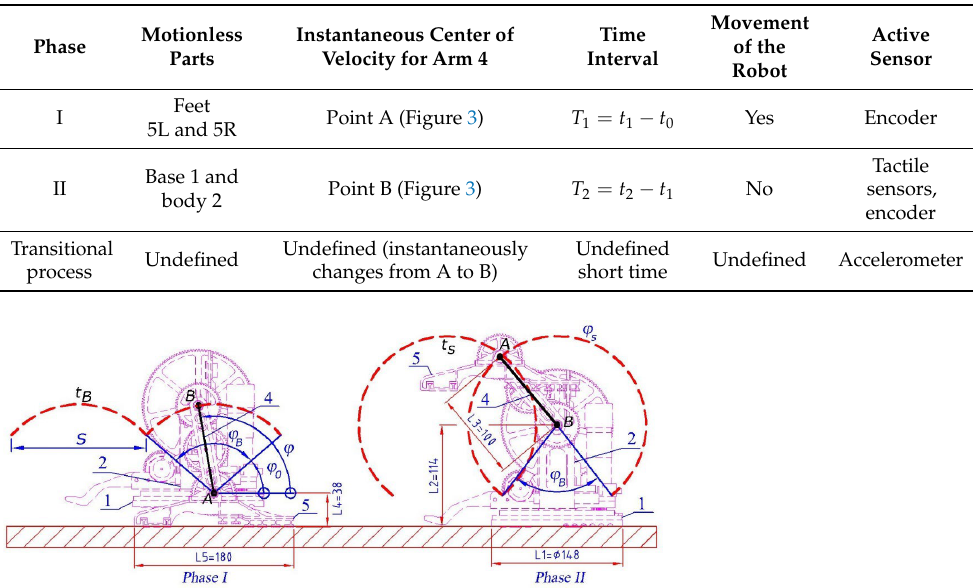
Figure 3. Walking phases (on even horizontal surface) for the robot “Big Foot”. The trajectory of the base (robot’s body) is t B while t s is the trajectory of the robot’s feet. The dimensions L j = 1 ÷ 5, are in millimeters.